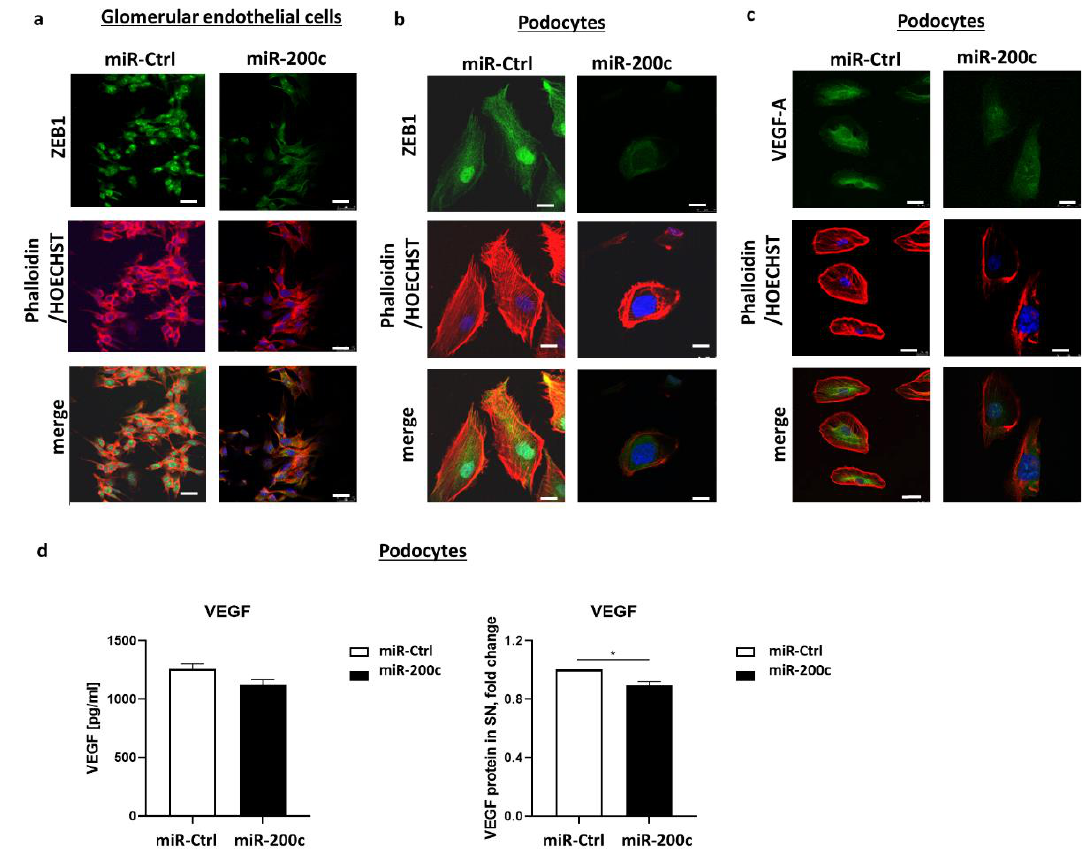
Figure 5. miR-200c overexpression decreases VEGF-A and ZEB1 on protein level. Images show immunofluorescent staining with phalloidin (red), anti-ZEB1 (green in ( a , b )) and anti-VEGF-A (green in ( c )). Nuclear staining is shown in blue with Hoechst. Scale bar = 25 µm. ( d ) VEGF protein in supernatant of cultured human podocytes (left panel shows total concentration, right panel shows fold change) after transfection with miR-200c mimic or miR-Ctrl was measured with ELISA. * p < 0.05.